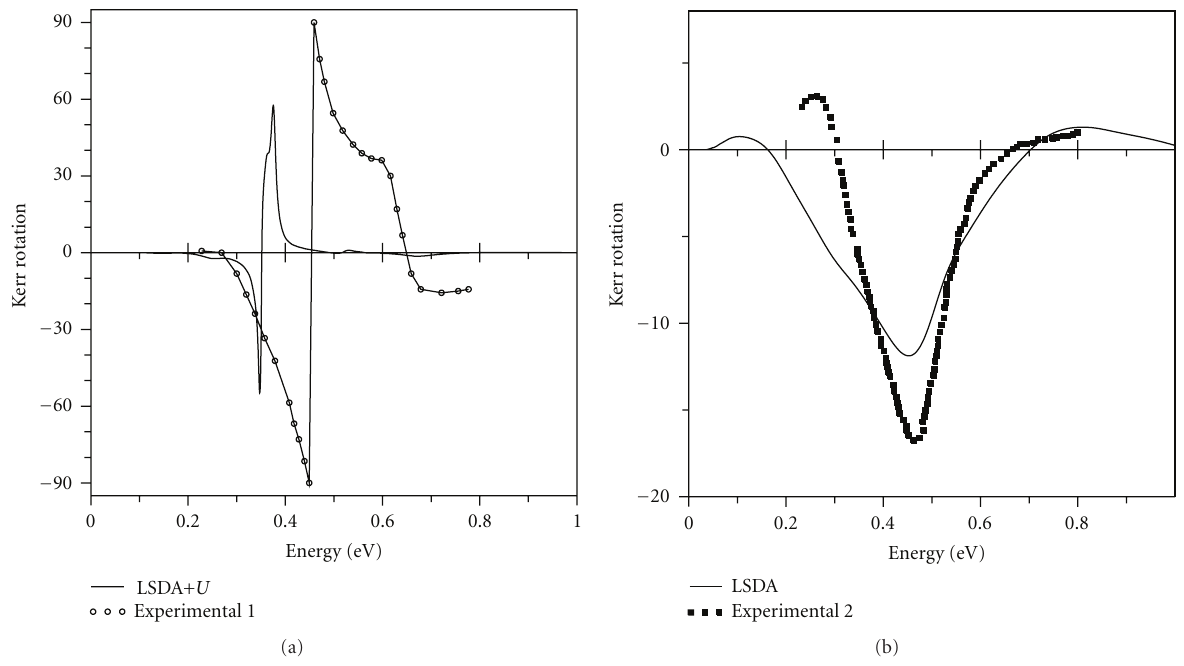
Figure 42: (a) Experimental [257] Kerr rotation (in degrees) of CeSb in comparison with LSDA+ U calculations [62]; (b) the LSDA theoret- ical spectrum [270] and experiment